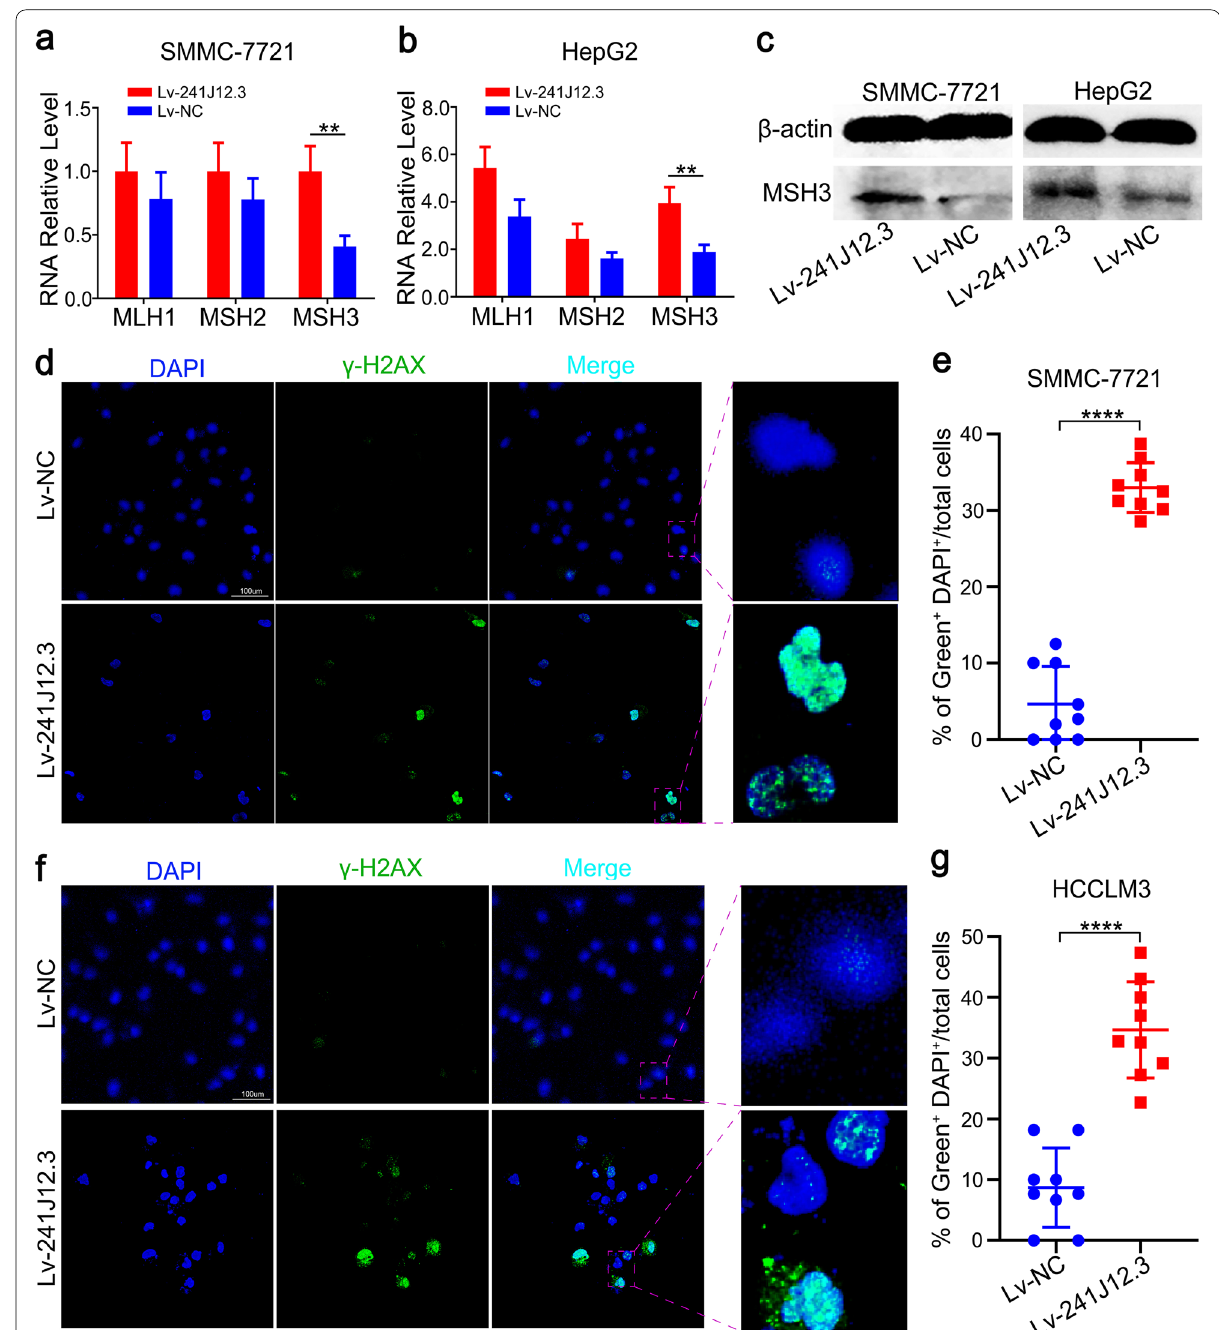
Fig. 6 LncRNA RP11-241J12.3 disrupted the MMR system. a‑b The mRNA levels of MLH1, MSH2 and MSH3 were upregulated after RP11-241J12.3 overexpression in HepG2 and SMMC-7721 cells. lcnRNA RP11-241J12.3 could regulate the expression of PC and MSH3 but not MSH2 or MLH1. c Western blot analysis showing upregulation of MSH3 following RP11-241J12.3 overexpression in SMMC-7721 and HepG2 cells. d Representative immunofluorescent staining and ( e ) quantification of γ-H2AX in SMMC-7721 cells transduced with Lv-241J12.3 or Lv-NC. f Representative immunostaining images and ( g ) statistical analysis of γ-H2AX in HCCLM3 cells transduced with Lv-241J12.3 or Lv-NC. The data represent the mean SD of at least three replicate ±